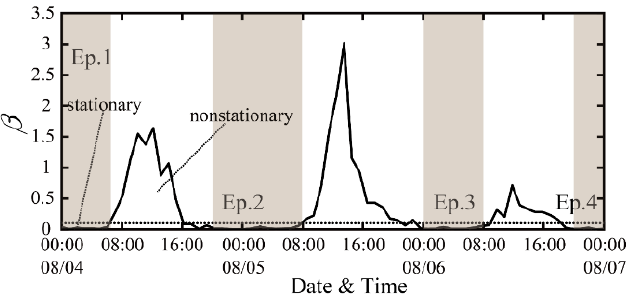
Figure 2. Hourly averaged values of 𝛽 from 4 – 6 August 2020. The dotted line represents 𝛽 = 0.1 . If 𝛽 exceeds 0.1, this episode is classified as nonstationary. Figure 1. Ep. ( 2 ), Ep. ( 3 ), and Ep. ( 4 ) were determined by 𝛽 < 0.1 ; these episodes are marked as having a brown shaded background. A dis- tinct stratification emerges with a dividing line of 𝛽 = 0.1 .